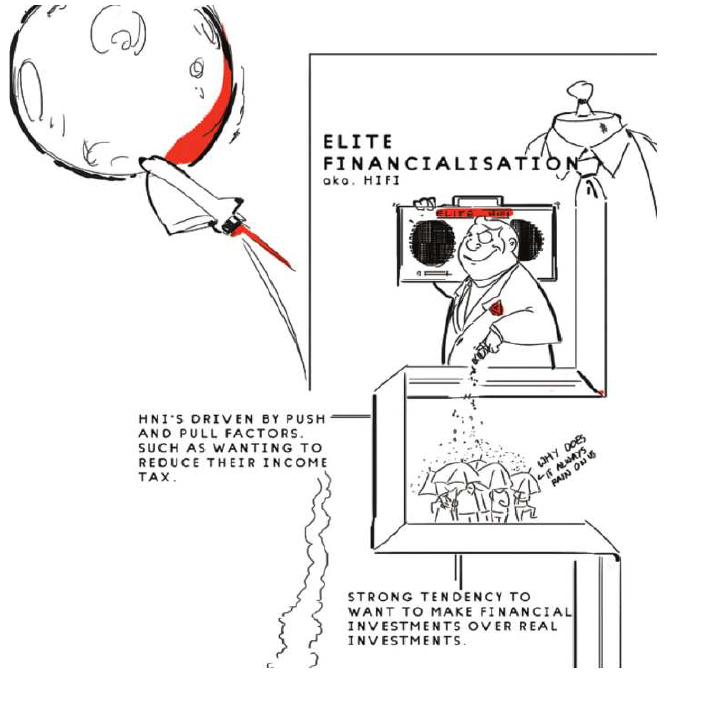
Source: Eduardo Bardi.